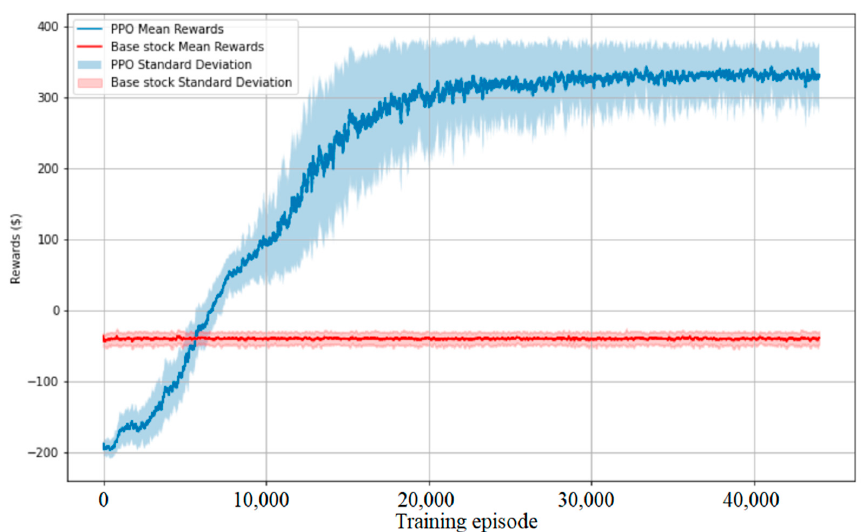
Figure 8. The PPO agent outcompetes the baseline base-stock policy by discovering a solution that exploits the simulation mechanics.